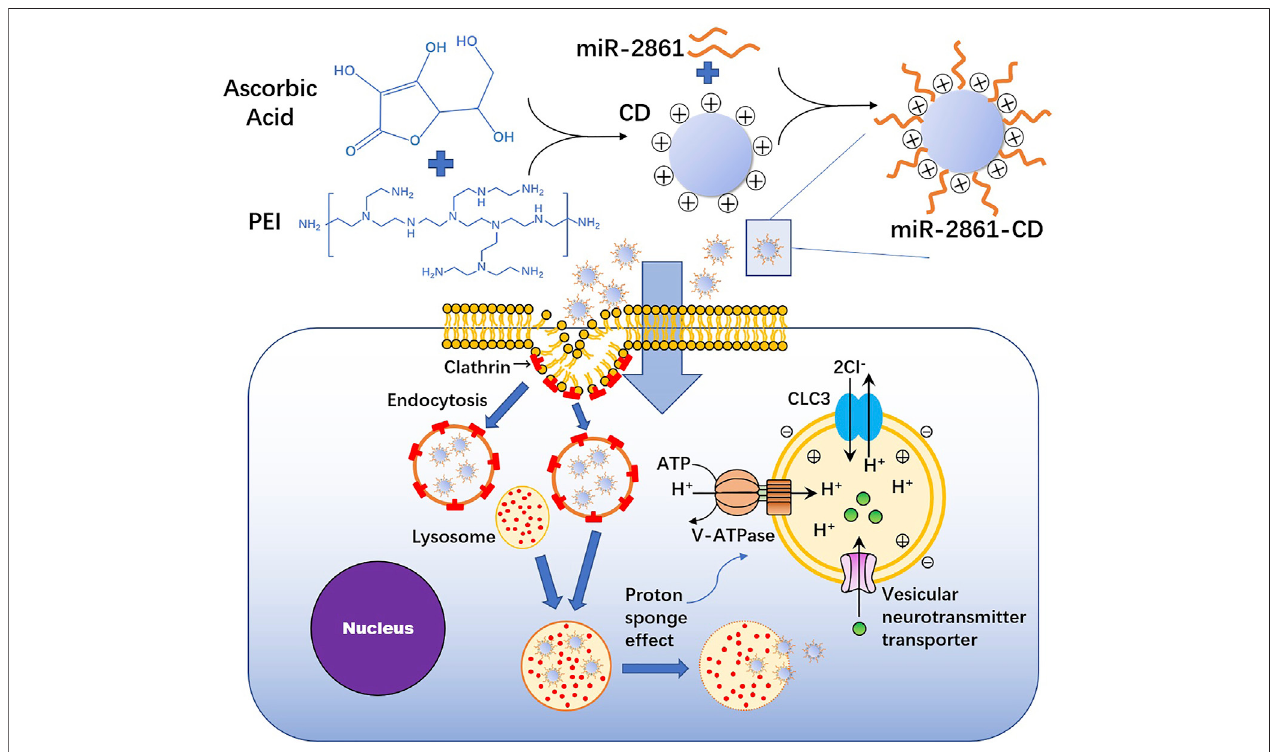
FIGURE 6 | The procession of ascorbic acid-PEI carbon dots (CD) transfecting miR-2861 into BMSCs.